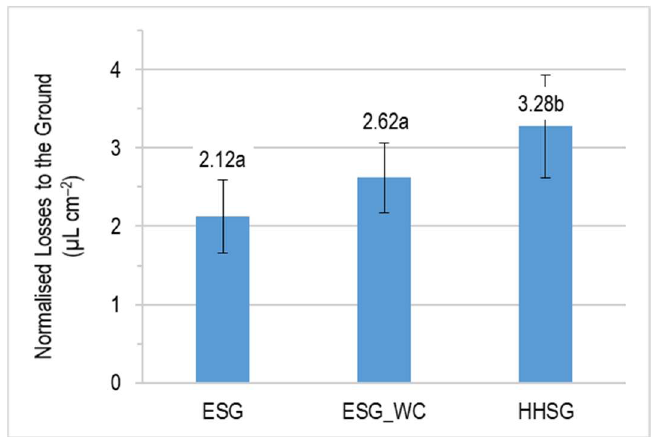
Figure 7. Normalised losses to the ground (µL cm −2 ). The same letter signifies no significant differences (Duncan’s test, p < 0.05). Bars signify the means ± SD of the data. ESG: Electrostatic Spray Gun; ESG_WC: Electrostatic Spray Gun Without Charge; HHSG: Hand-Held Spray Gun. The losses to the ground in the outer zone of the plant canopy (depths D1 and D4, In both zones, the losses to the ground were lower for the electrostatic spray gun, with values of 2.36 and 1.64 µL cm −2 in the outer and inner zones, respectively. Conversely, the greatest losses to the ground occurred with the hand-held spray gun, with values of 3.66 and 2.51 µL cm −2 , in the outer and inner zones, respectively. Table 4. Normalised losses to the ground in the outer and inner zones (mean ± SD) in µL cm −2 . Equipment * Outer